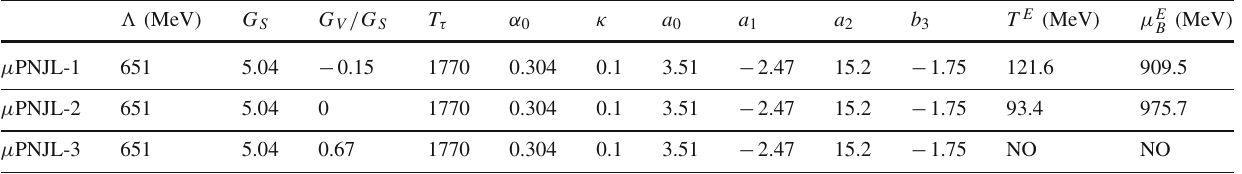
Table 3 Three parameters sets used in the μ PNJL model, and the corresponding critical temperatures and chemical potentials at the critical end